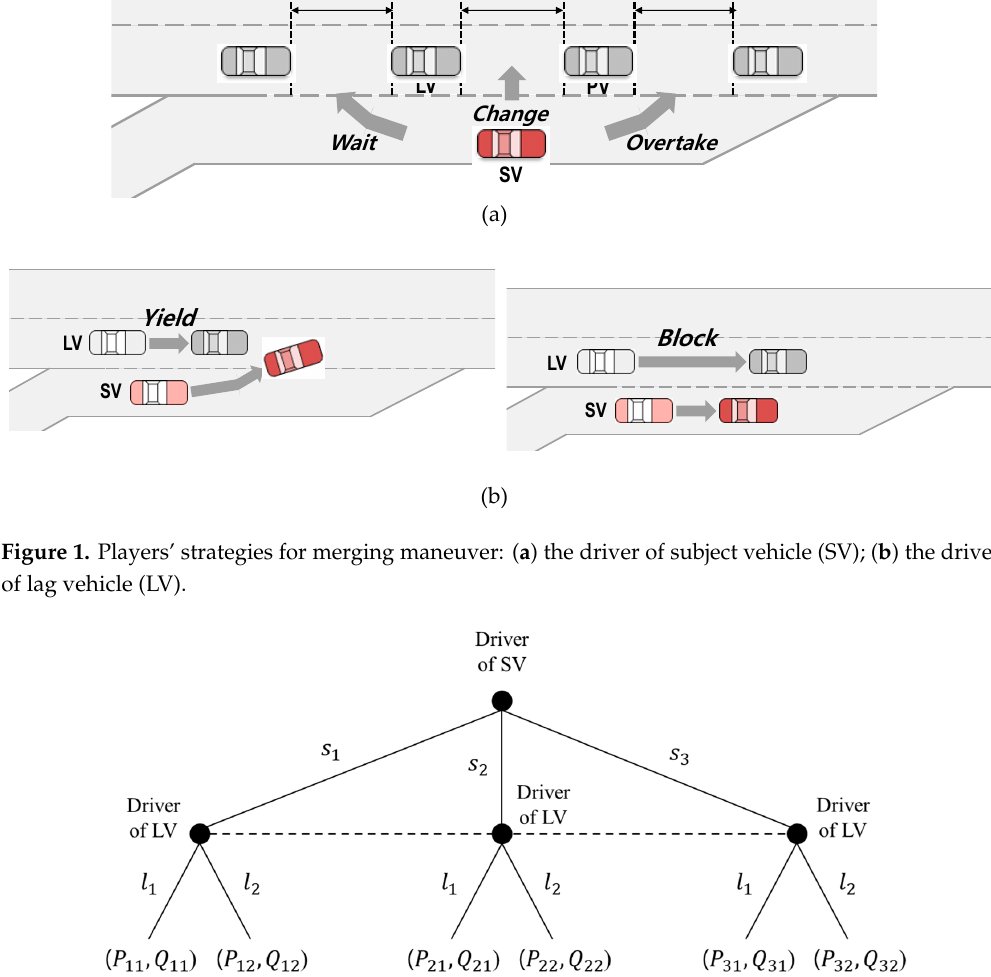
Figure 1. Players’ strategies for merging maneuver: ( a ) the driver of subject vehicle (SV); ( b ) the driver of lag vehicle (LV).